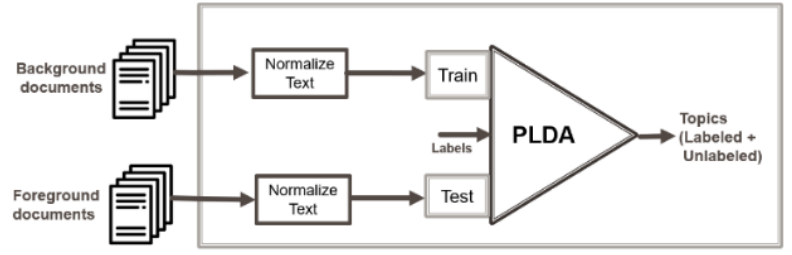
Figure 4. PLDA for background and foreground